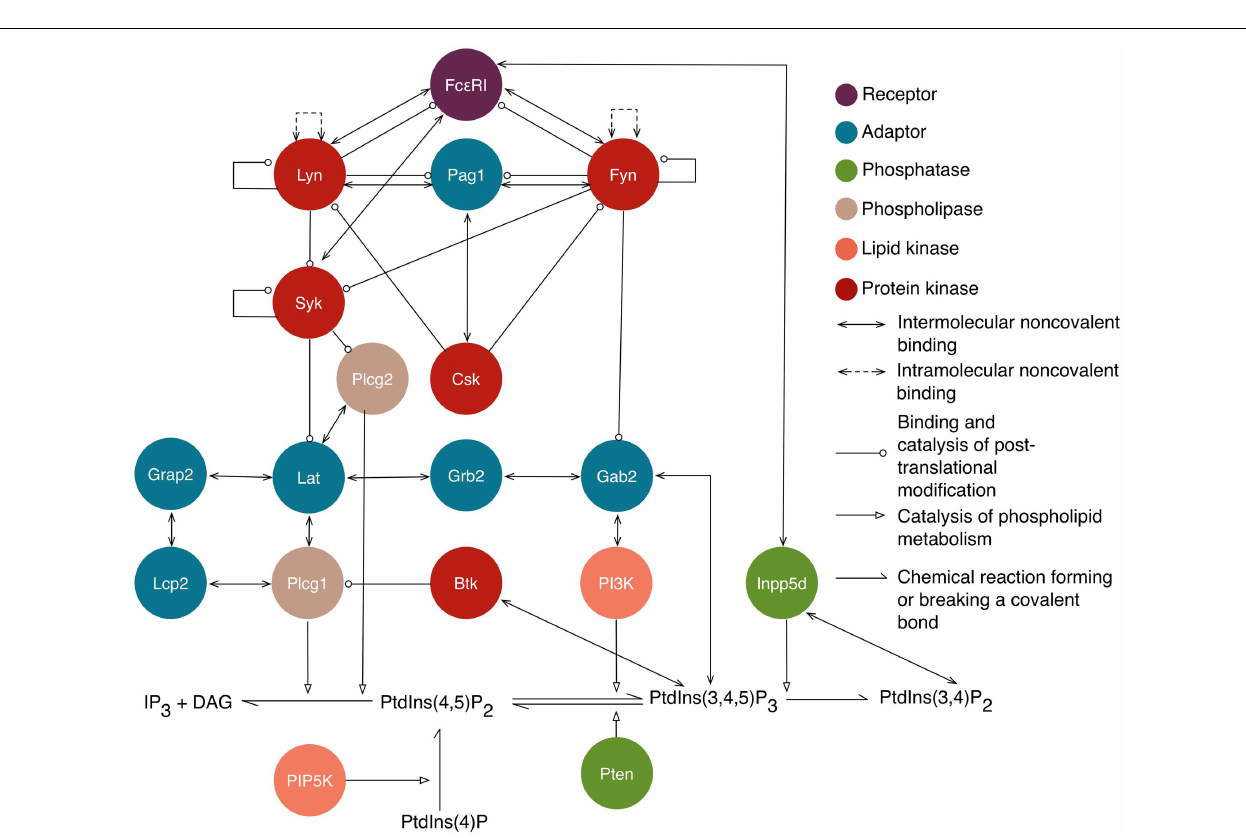
different types of interactions and influences. Reactions of lipid species are illustrated at the bottom. Arrows from proteins that point to lipid reactions indicate that the reaction is catalyzed by that protein. Arrows from protein to lipid species indicate that the protein binds that lipid. Not shown are implicit phosphatase reactions that cause dephosphorylation of all sites that can be phosphorylated. Ligand–receptor interactions are shown in Figure 2 . A subset of interactions is illustrated with site-specific detail in Figure 3 .